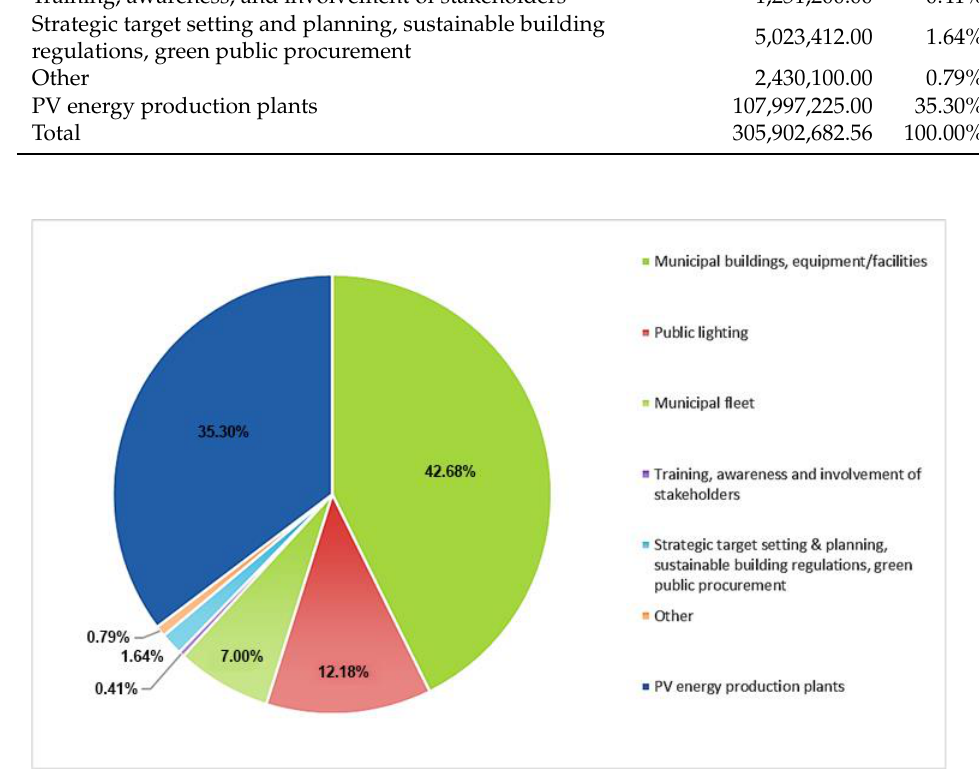
Figure 5. SEAP resources for Public Administration.